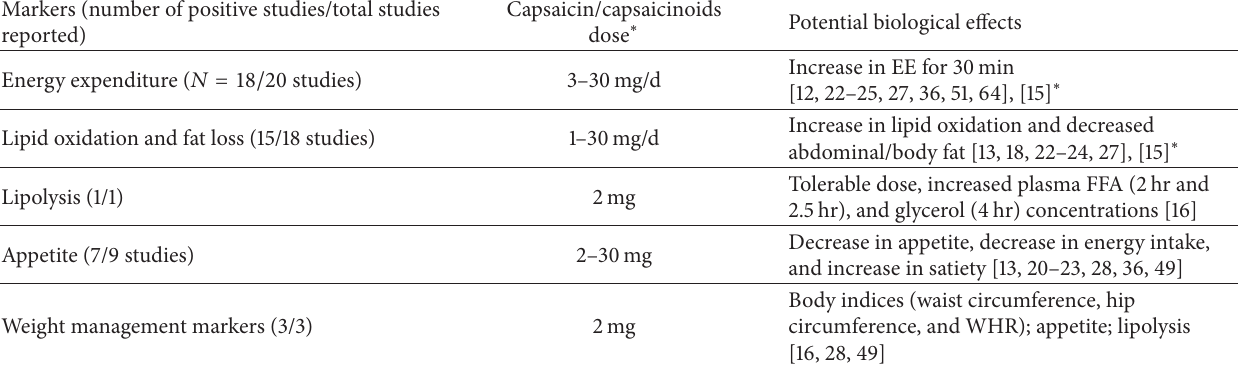
Table 2: Capsaicinoids effects on potential markers of weight